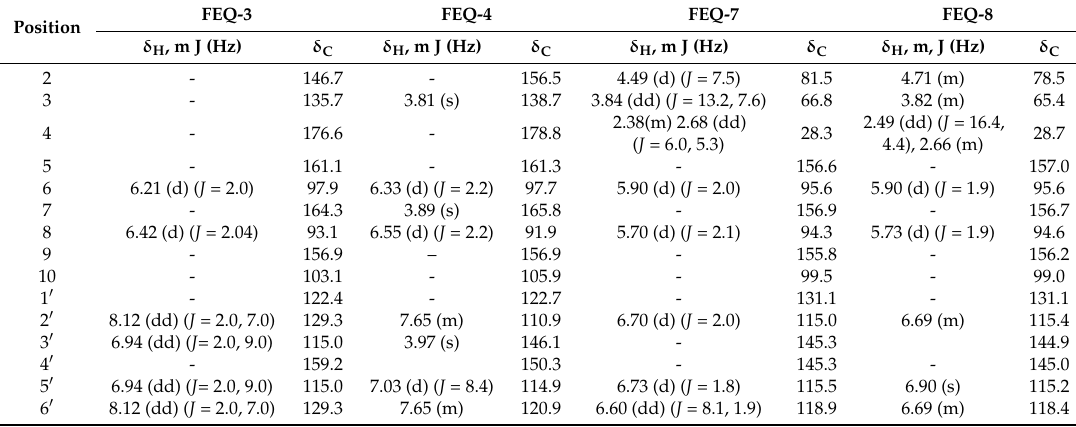
Table 6. 1 H, 13 C-NMR chemical Shifts (ppm) of the four aglycone flavonoids isolated from E. spiralis methanol